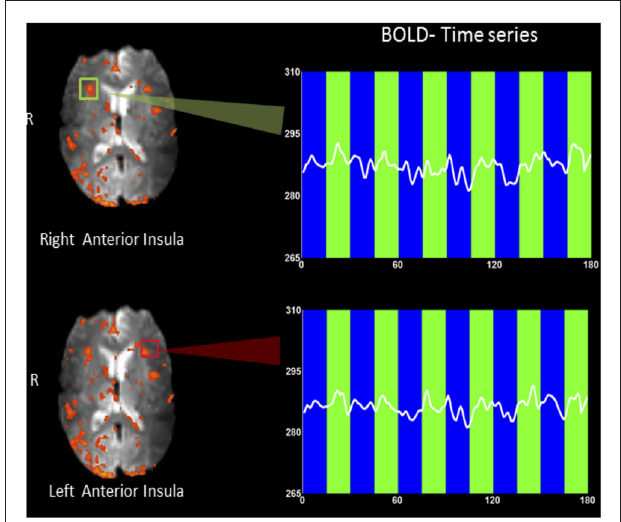
FIGURE 3 | An example rtfMRI run showing the up-regulation of BOLD response in the predetermined regions of interest (ROIs) of right (green rectangle) and left (red rectangle) anterior insula, overlaid on a mean EPI brain image. Mean BOLD signals were extracted from each of the two ROIs and are presented overlaid on baseline (blue bars) and up-regulation (green bars) blocks. A moderate increase in BOLD signal in both left and right insula (higher amplitude) was observed during regulation blocks as compared to baseline